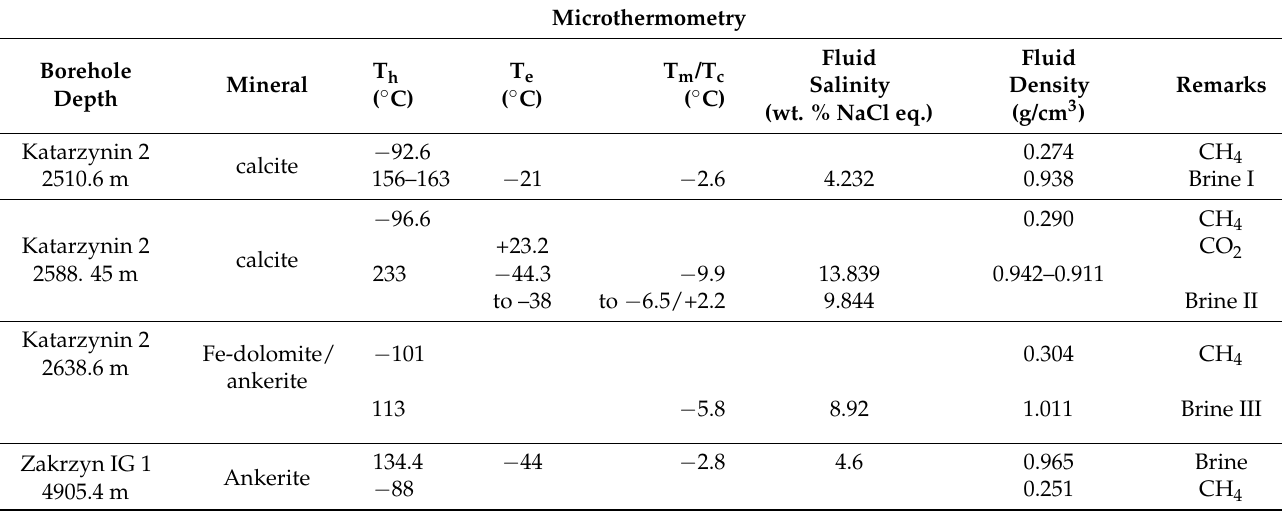
Table 6. Interpretation of the microthermometry results for the primary fluid inclusions in calcite and Fe-dolomite/ankerite. Microthermometry